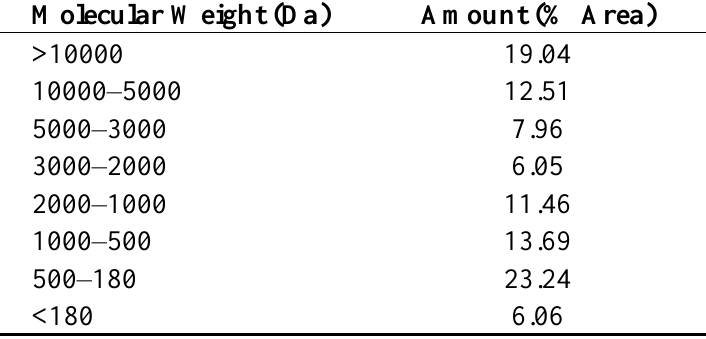
Table 4. The molecular weight distribution of Flavourzyme hydrolysate from defatted corn